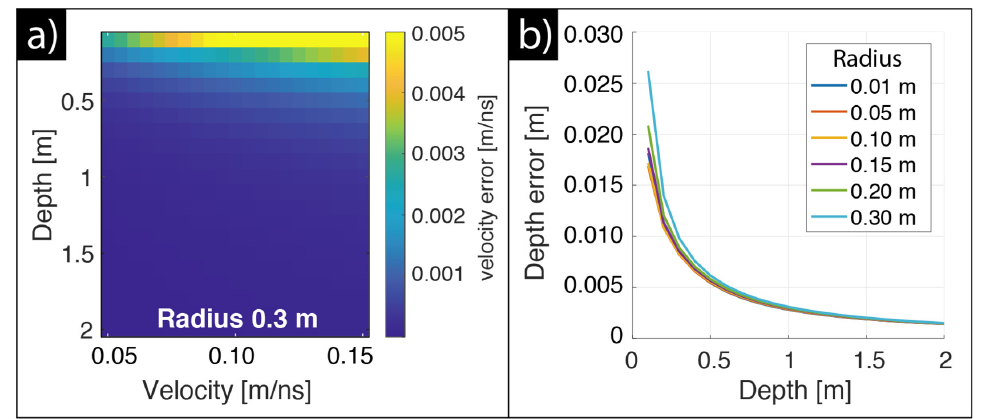
Figure 10. Velocity error ( a ) and depth error ( b ) for different depths and velocities if only the right radius of the object is taken into account, but zero offset. The depth error is independent of velocity.